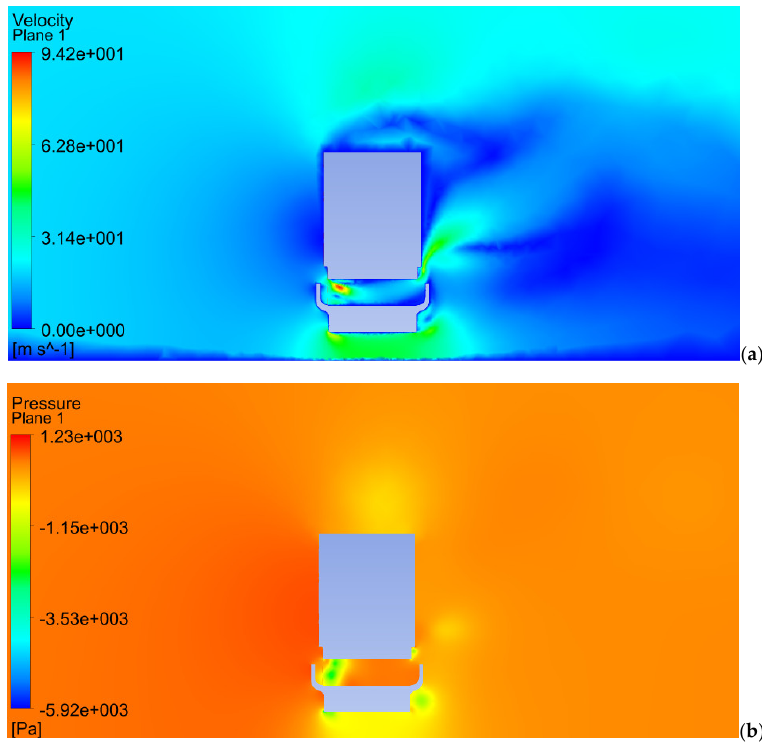
Figure 8. ( a ) Velocity map for the cross-wind speed 20 m/s, visible in the middle plane between the platform bogies, ( b ) pressure map for the cross-wind speed 20 m/s. Selected results of aerodynamic forces, torques, and coefficients calculated in the CFD simulations in reference to the relative airflow velocity components are presented in Table 3. Relative airflow components are given in the fixed reference frame, and reaction torque is calculated according to Equation (18) for two cases: transported semi-trailer empty and fully loaded ( b = 1 m, h = 1.7 m). Table 3. Selected results of aerodynamic forces, torques, and coefficients calculated in CFD simula- tions. No.